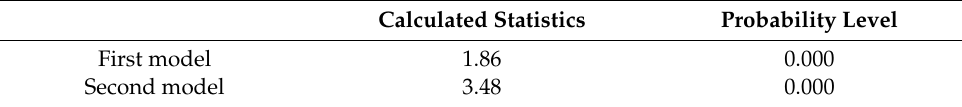
Table 8. The integration test results.